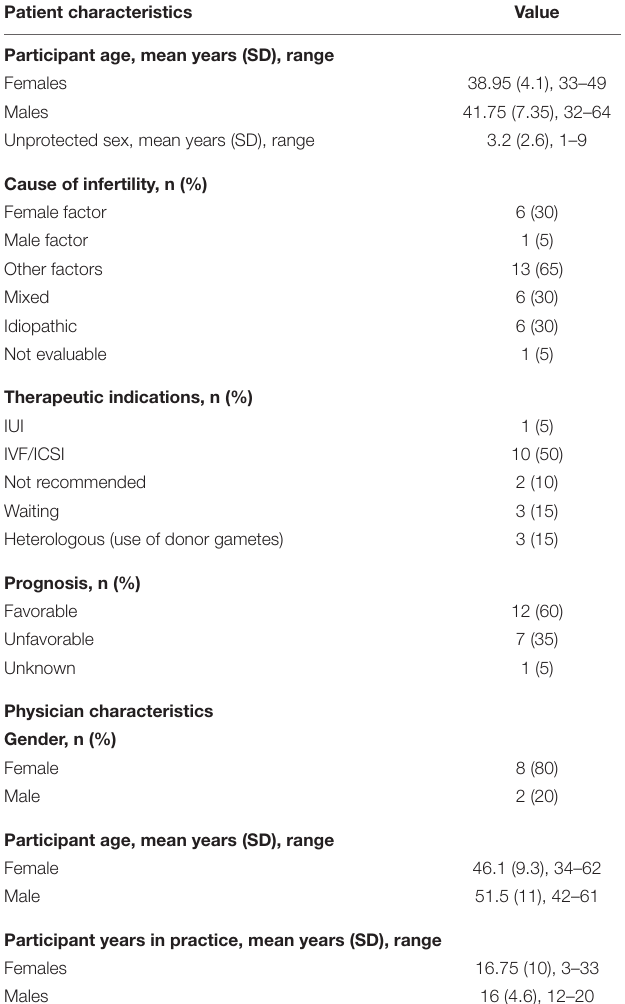
TABLE 1 | Participant sociodemographic and clinical